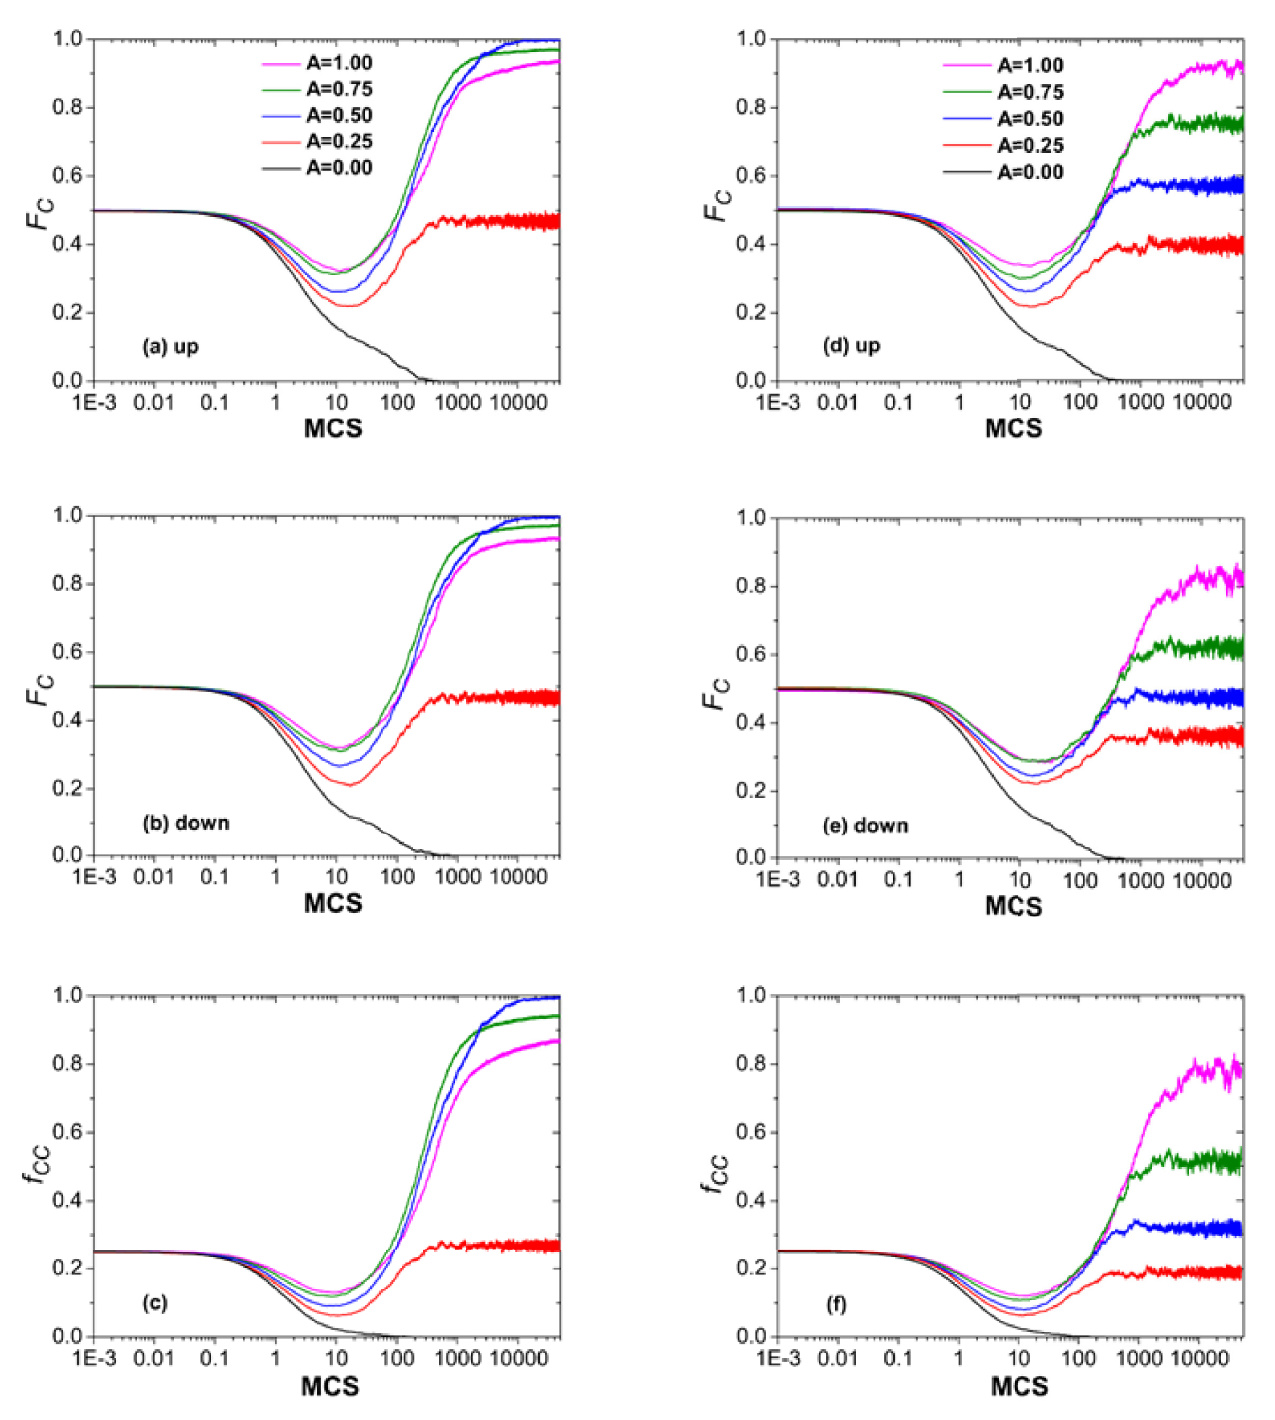
Fig 2. Time evolution of fraction of cooperators and cooperative pairs between two interdependent networks. The left three panels (a, b, c) depict the time course of evolution under the case I , where the corresponding players hold the same interdependency taken from the interval [ − 1,1] (i.e., A = 1) according to Eq (2). Panel (a) and (b) denote the fraction of cooperators on the upper lattice and lower one, respectively, and panel (c) represents the fraction of cooperative pairs which means the corresponding players are both cooperators on these two lattices. While for the case II in which each individual takes the interdependency value between − 1 and 1, the right three panels, from panel (d) to (f), describe the time evolution of corresponding quantities. The defection parameter b is fixed to be b = 1.05, other parameters are set to be L = 200 and K =